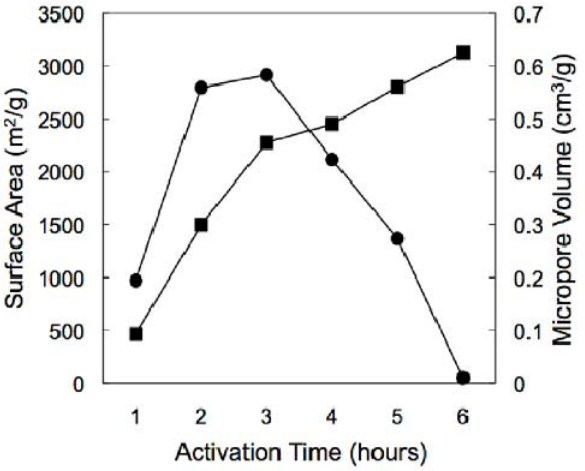
Figure 9. BET surface area ( (cid:31) ) and micropore volume ( (cid:32) ) for the activated CAs as a function of activation